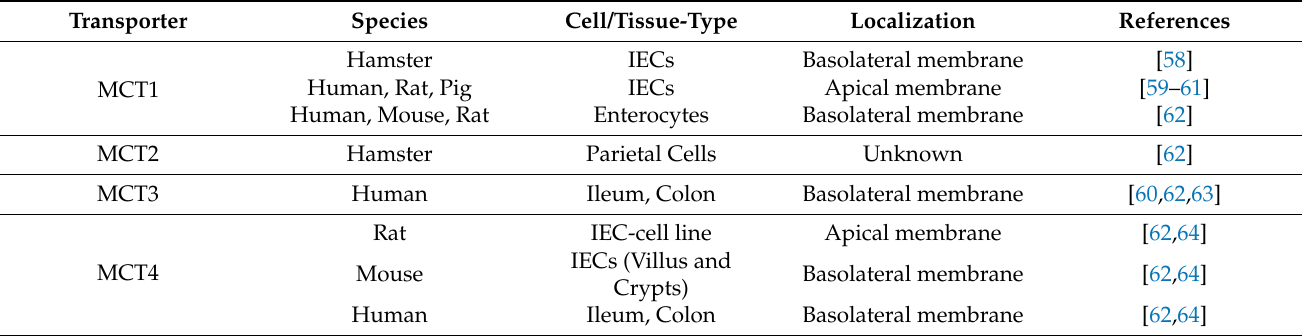
Table 2. Distribution and localization of monocarboxylic acid transporters (MCTs) among various species.